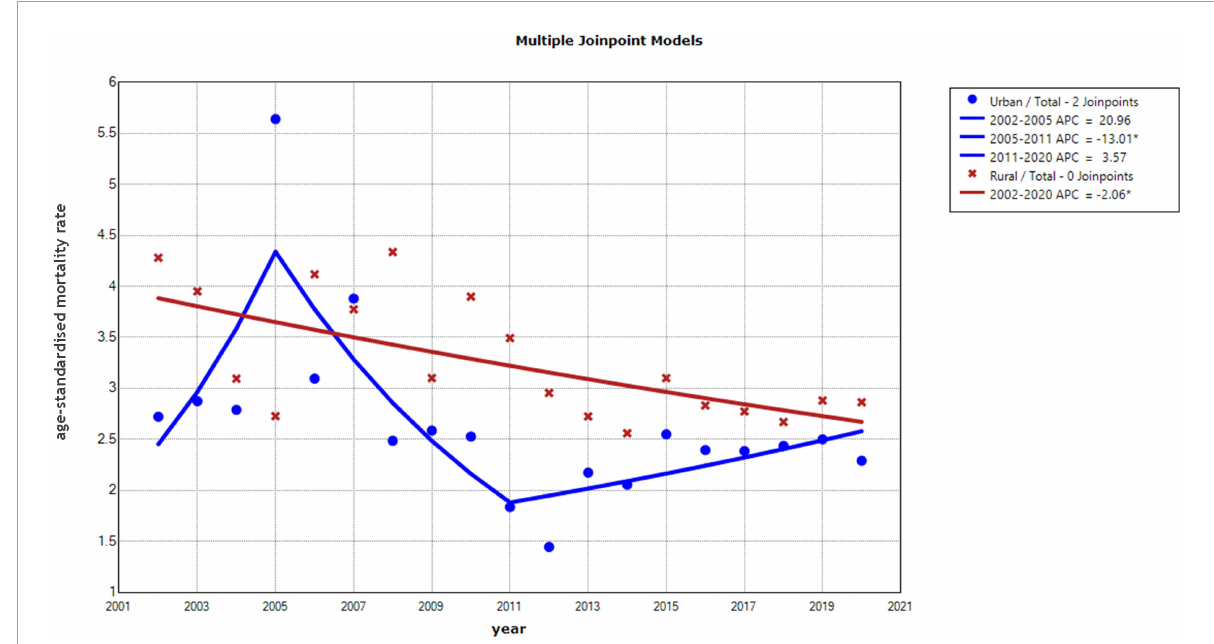
FIGURE1 Annual percentage change (APC) in the trend of age-standardized mortality rates for Chinese residents by region from 2002 to 2020.